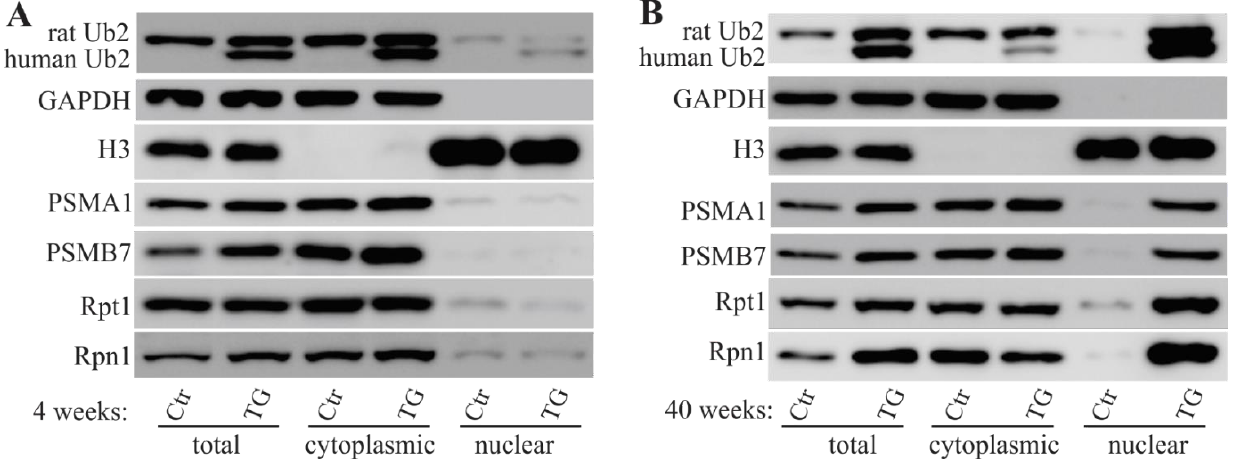
Figure 3. Altered proteasome subunit expression in mutant UBQLN2 rats. Cell fractionation revealed the expressions of proteasome subunits. Rat forebrains were dissected from mutant Ubqln2 transgenic (TG) and non-transgenic (Ctr) rats and tissue lysates were fractionated into nuclear and cytoplasmic components. The nucleus marker (histone 3: H3) and the cytoplasmic marker (GAPDH) were used to determine fractionation effectiveness. Human UBQLN2 and rat Ubqln2 (Ub2) were detected as two separate bands. The proteasome subunits PSMA1, PSMB7, Rpt1, and Rpn1 were examined in 4-week-old rats ( A ) and in 40-week-old rats ( B ).